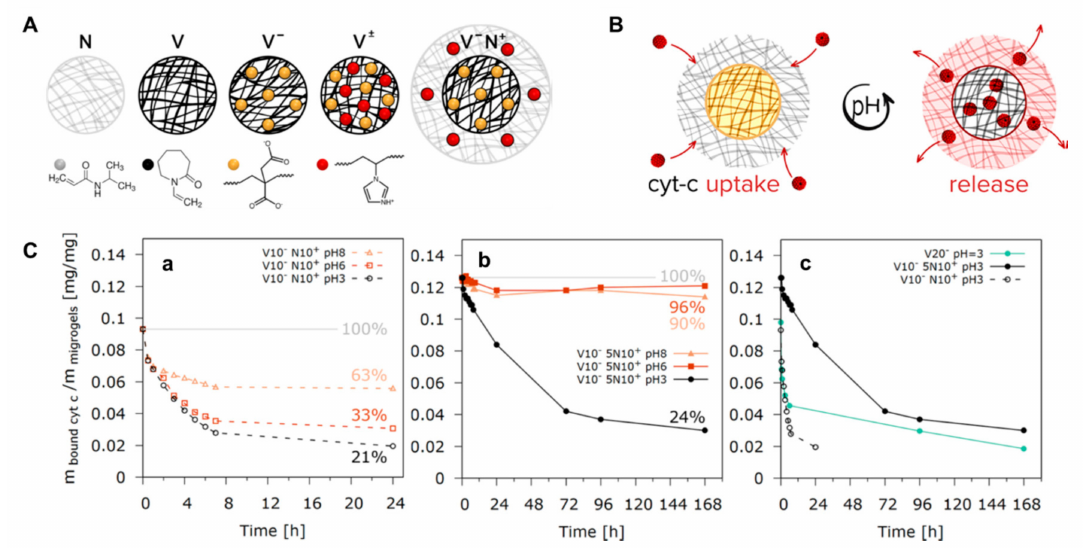
Figure 4. ( A ) Designing microgels for loading and release of the model protein, cytochrome c (cyt-c), by changing the distribution of ionizable groups into the microgel structure: N -pure PNIPAM microgel; V-pure PVCL microgel; V − -anionic PVCL microgel; V ± -PVCL polyampholyte microgel with a random distribution of ionizable groups; V − N + -core − shell polyampholyte microgel consisting of an anionic PVCL core (black network) and a cationic PNIPAM shell (grey network); ( B ) Schematic representation of the protein loading and release into / from the polyampholyte microgels by reversibly changing the hydrogel charges from positive to negative using the pH switch from acidic to basic; ( C ) E ff ect of changing the pH value from 8 to 6, and respectively 3, on the amount of bound cyt-c for the polyampholyte microgels comprising of V10 − N10 + ( a ) and V10 − 5N10 + ( b ); Variation of the amount of bound cyt-c vs. time at pH 3 for V10 − N10 + and V10 − 5N10 + polyampholyte core-shell microgels in comparison to the V20 − polyelectrolyte microgels ( c )